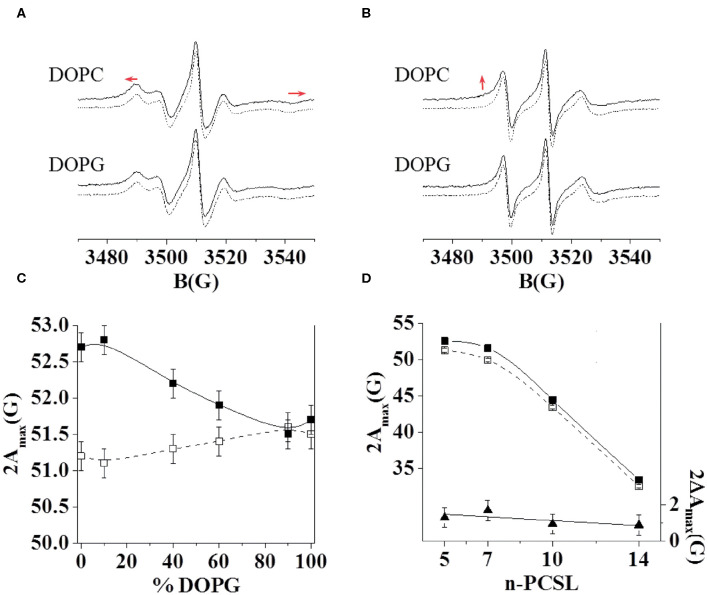
ESR spectra of 5-PCSL (A) and 14-PCSL (B) in lipid bilayers of DOPC and DOPG in the absence (dashed lines) and presence (continuous lines) of the C8 peptide. In (A) the red arrows highlight the shift of the low-field maximum and high-field minimum. In (B) the red arrow highlights the evidence of a second component in the spectrum registered in the presence of C8. 5-PCSL dependency on the DOPG percentage in the lipid bilayer composition of the outer hyperfine splitting, 2Amax
(C), in the absence (open squares, dashed line) and in the presence of the C8 peptide (solid squares, continuous line). n-PCSL dependency on spin-label position, n, of the outer hyperfine splitting, 2Amax (D, left-hand ordinate), in DOPC membranes in the absence (open squares, dashed line) and in the presence of the C8 peptide (solid squares, continuous line); to better highlight the 2Amax variation due to the presence of the peptide, the dependency on n of the difference between the 2Amax values in the presence of the C8 peptide and in its absence is also reported (D, right-hand ordinate, solid triangles).